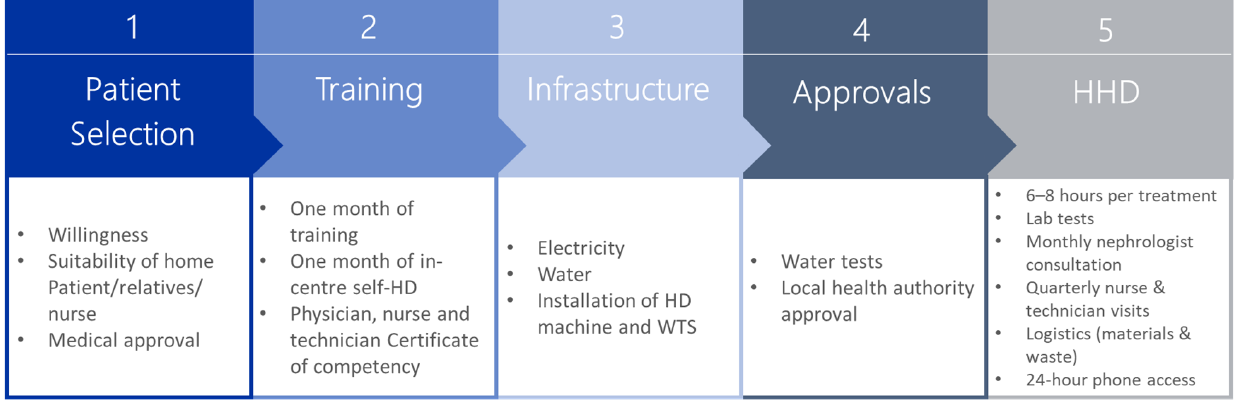
Table 3. The main pillars of care networks and associated activities.